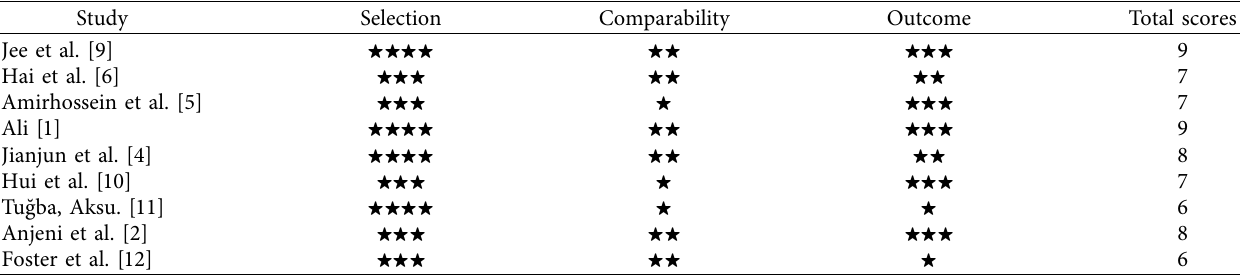
Table 2: Newcastle-Ottawa Scale scores for the included